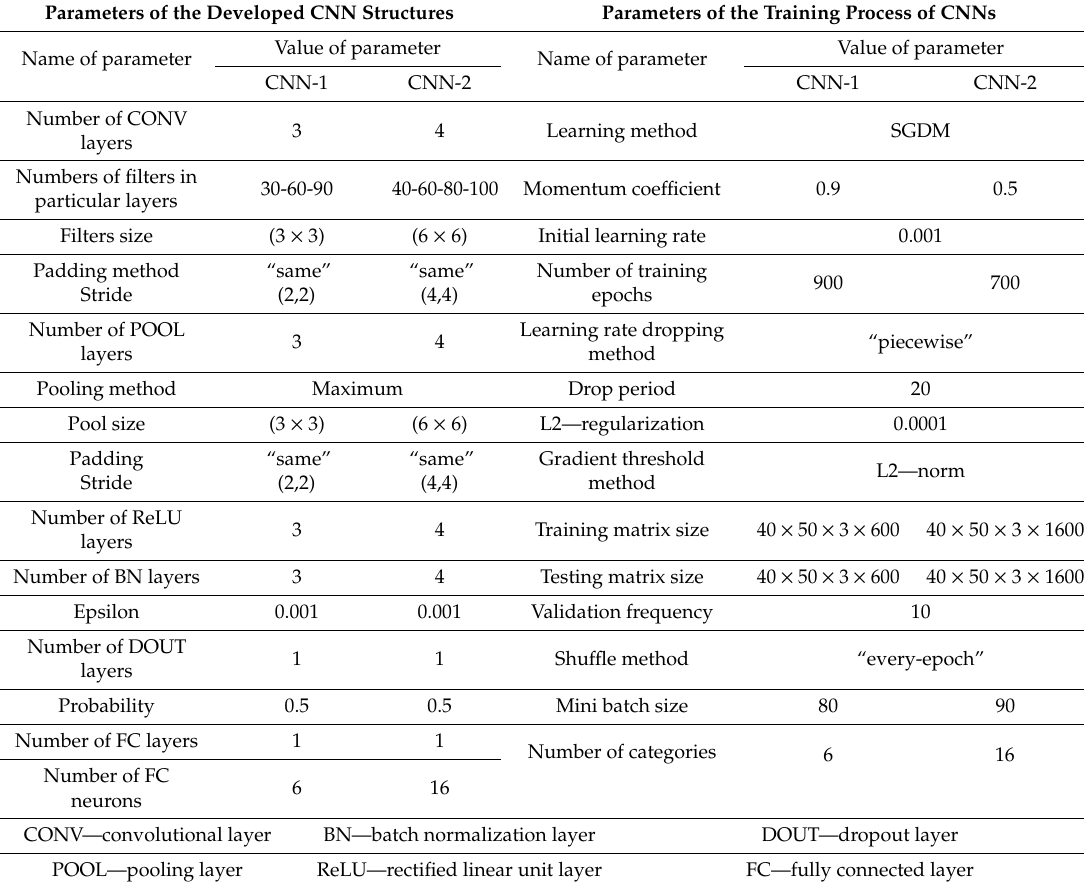
Table 1. Parameters of structures and training process of the developed